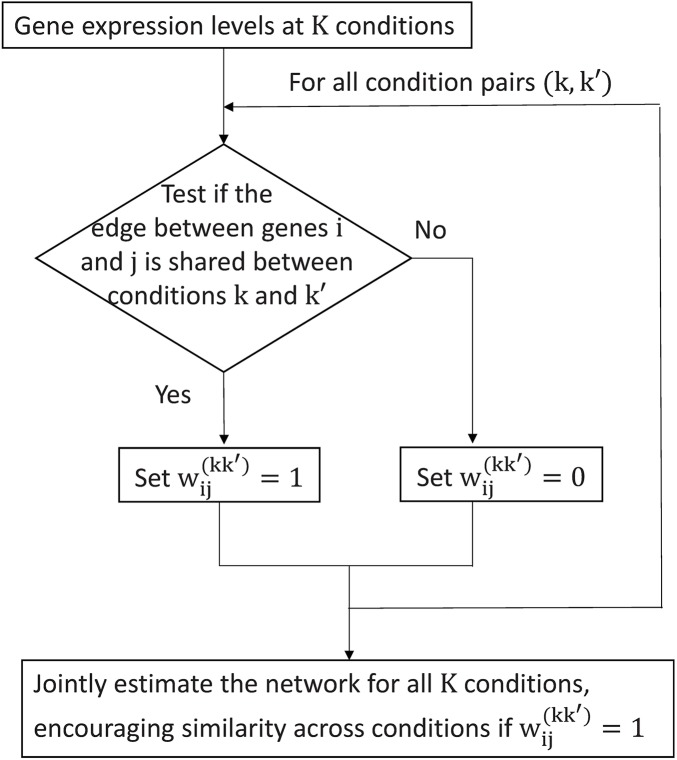
The computational workflow of our method.